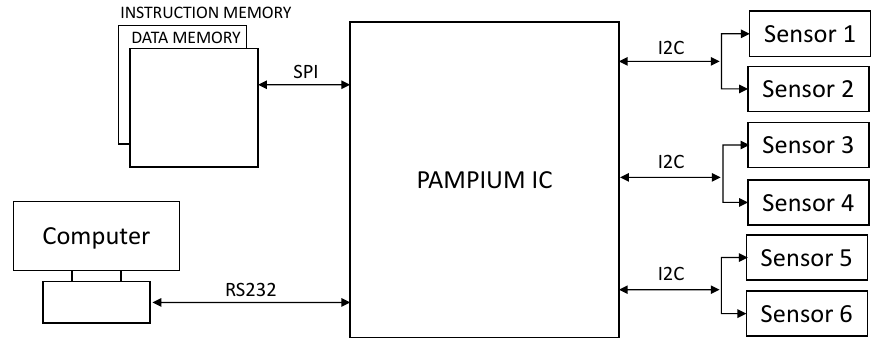
Figure 20. Sensor system using